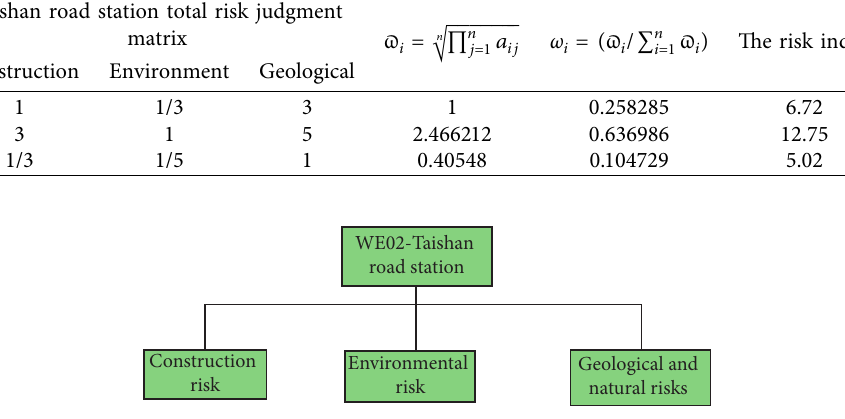
Figure 10: Total risk hierarchy of Taishan road